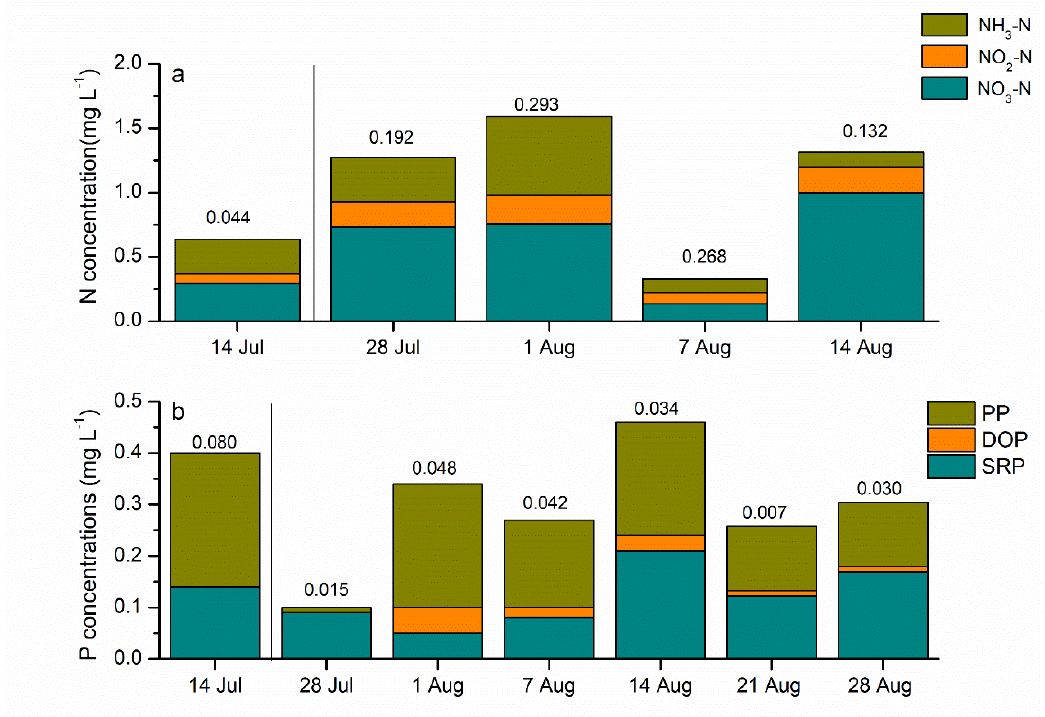
Figure 3. Concentrations of different forms of N ( a ) and P ( b ) in Lake Yuehu. The numbers above dates are the standard deviation of dissolved inorganic of N (DIN) and total P (TP) of the three sites. The left side of the line indicates the period before water diversion; the right side indicates the period after water diversion.